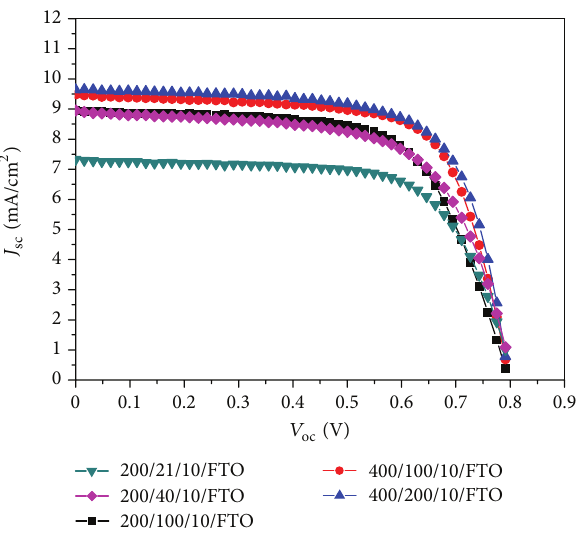
Figure 12: The EIS curves of DSSCs with the triple layer structures with different particle sizes of TiO 2